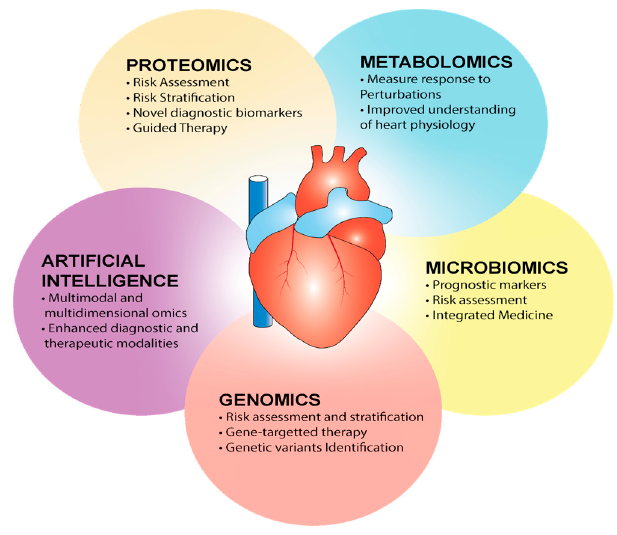
Figure 3. Domains of precision medicine in